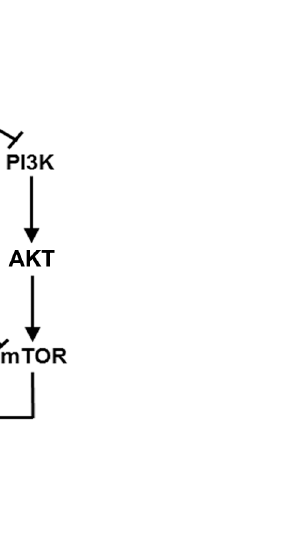
Fig 6. Schematic diagram showing the proposed autophagic signaling pathways triggered by PP7 in HepG2 cells.